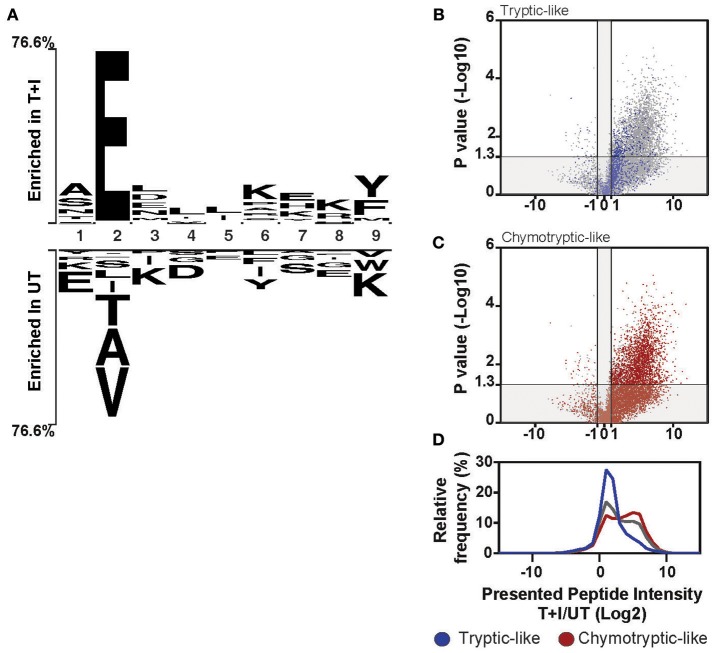
Induction of HLA-B changes the overall motif of presented peptides. (A) The motif of the top 25% (Enriched in T+I) of 9-mer peptides based on the ranking in Figure S9E is compared to the bottom 25% (Enriched in UT). The residues that are enriched at each position are displayed above or below the axis (B–D) Peptides were classified as tryptic-like (K, R c-terminal residues) or chymotryptic like (A,F,I,L,M,V,Y c-terminal residues). The fold change in intensity for each peptide between TNFα and IFNγ stimulated (T+I) and unstimulated cells (UT; Log2 transformed) was plotted against the p-value for the difference between the two treatment groups (two-tailed t-test, –Log10 transformed). The peptides, which are tryptic-like (B, blue dots) or chymotryptic-like (C, red-dots), are overlaid on the background of all peptides identified along with the histogram of intensity fold changes for these three groups of peptides (D; tryptic-like, chymotryptic-like and other).